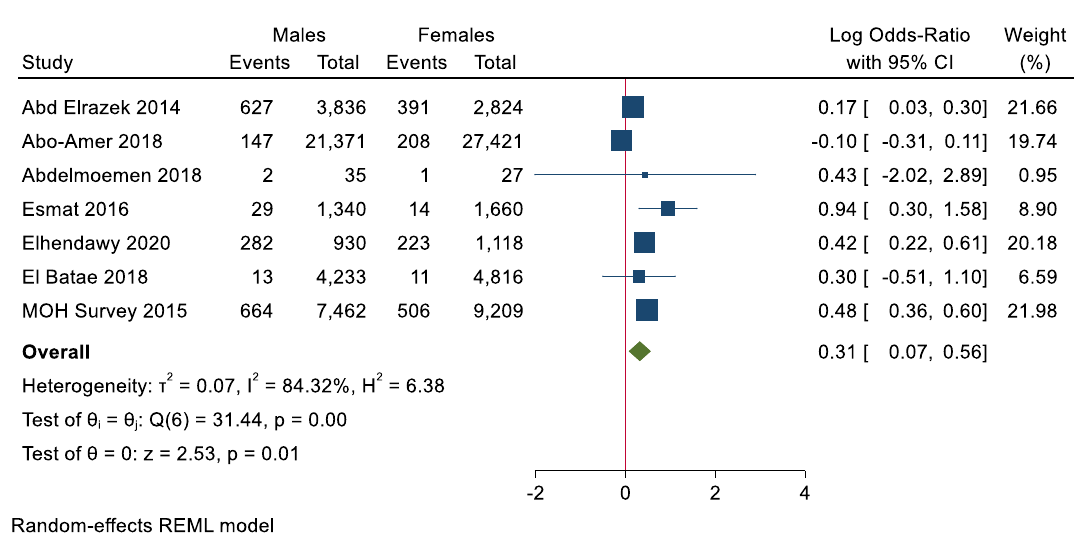
Figure 7. Forest plot of prevalence of HCV RNA in males and females in adults. There is statistically significant increase in prevalence of HCV RNA in males than females in